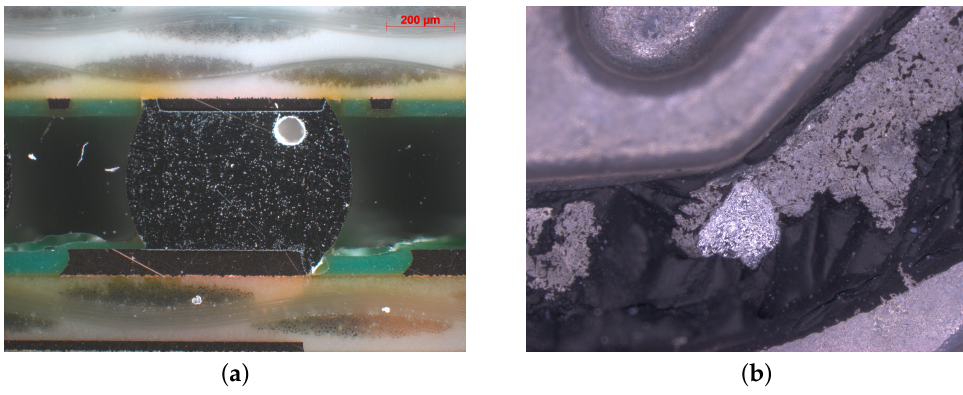
Figure 2. Example images from the Bosch industrial dataset ( a ) shows cross-section image example, ( b ) shows sample image with other